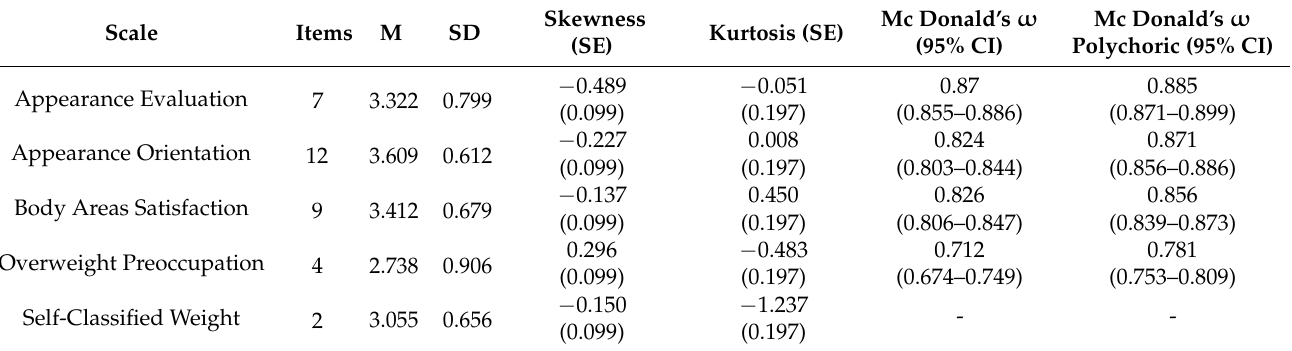
Table 2. Descriptive Statistics and Internal Consistency for the MBSRQ-AS Scales ( n = 614).